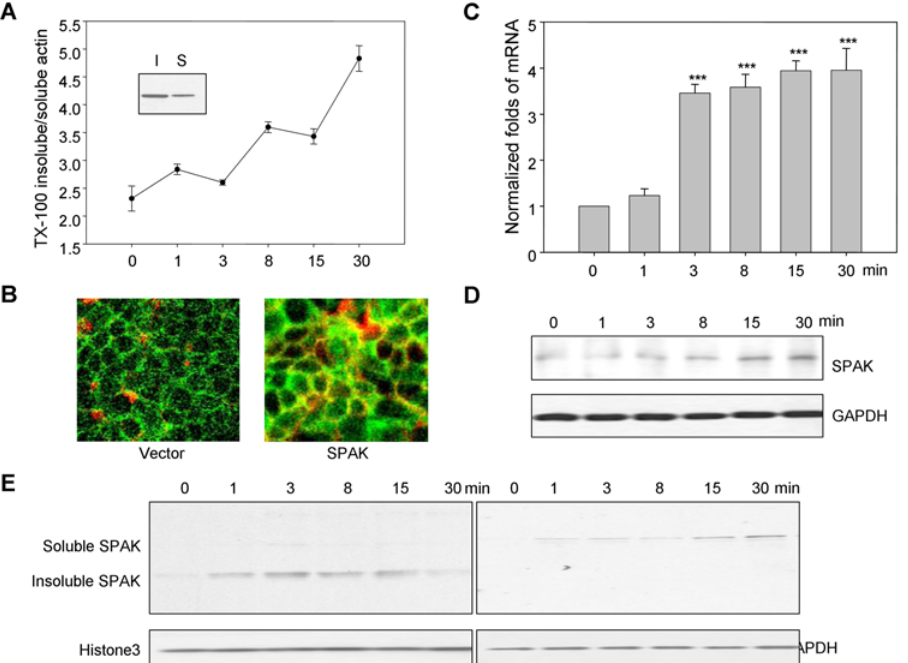
Figure 3. SPAK expression in hyperosmolarity treated Caco2-BBE cells. A. Graph of ratio of triton x-100 insoluble actin v.s. soluble actin and western blot. B. Immunostaining of SPAK in colonic Caco2-BBE cells treated with hyperosmolarity at 0 and 15 min. SPAK (green); actin by rhodamine (red). (C) Real time PCR and (D) Western blot demonstrated that treatment of hyperosmolarity increases SPAK expression with GAPDH as internal loading control, ** p , 0.01, *** p , 0.001. E. Western blot showed that SPAK expression is increased by hyperosmolarity and is recruited to the triton-